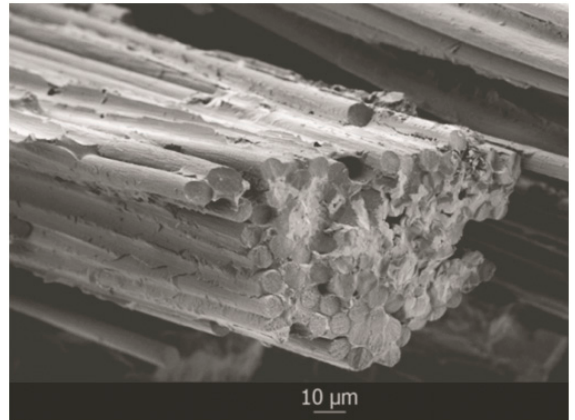
/ SiC composite material after the 3-point bending f